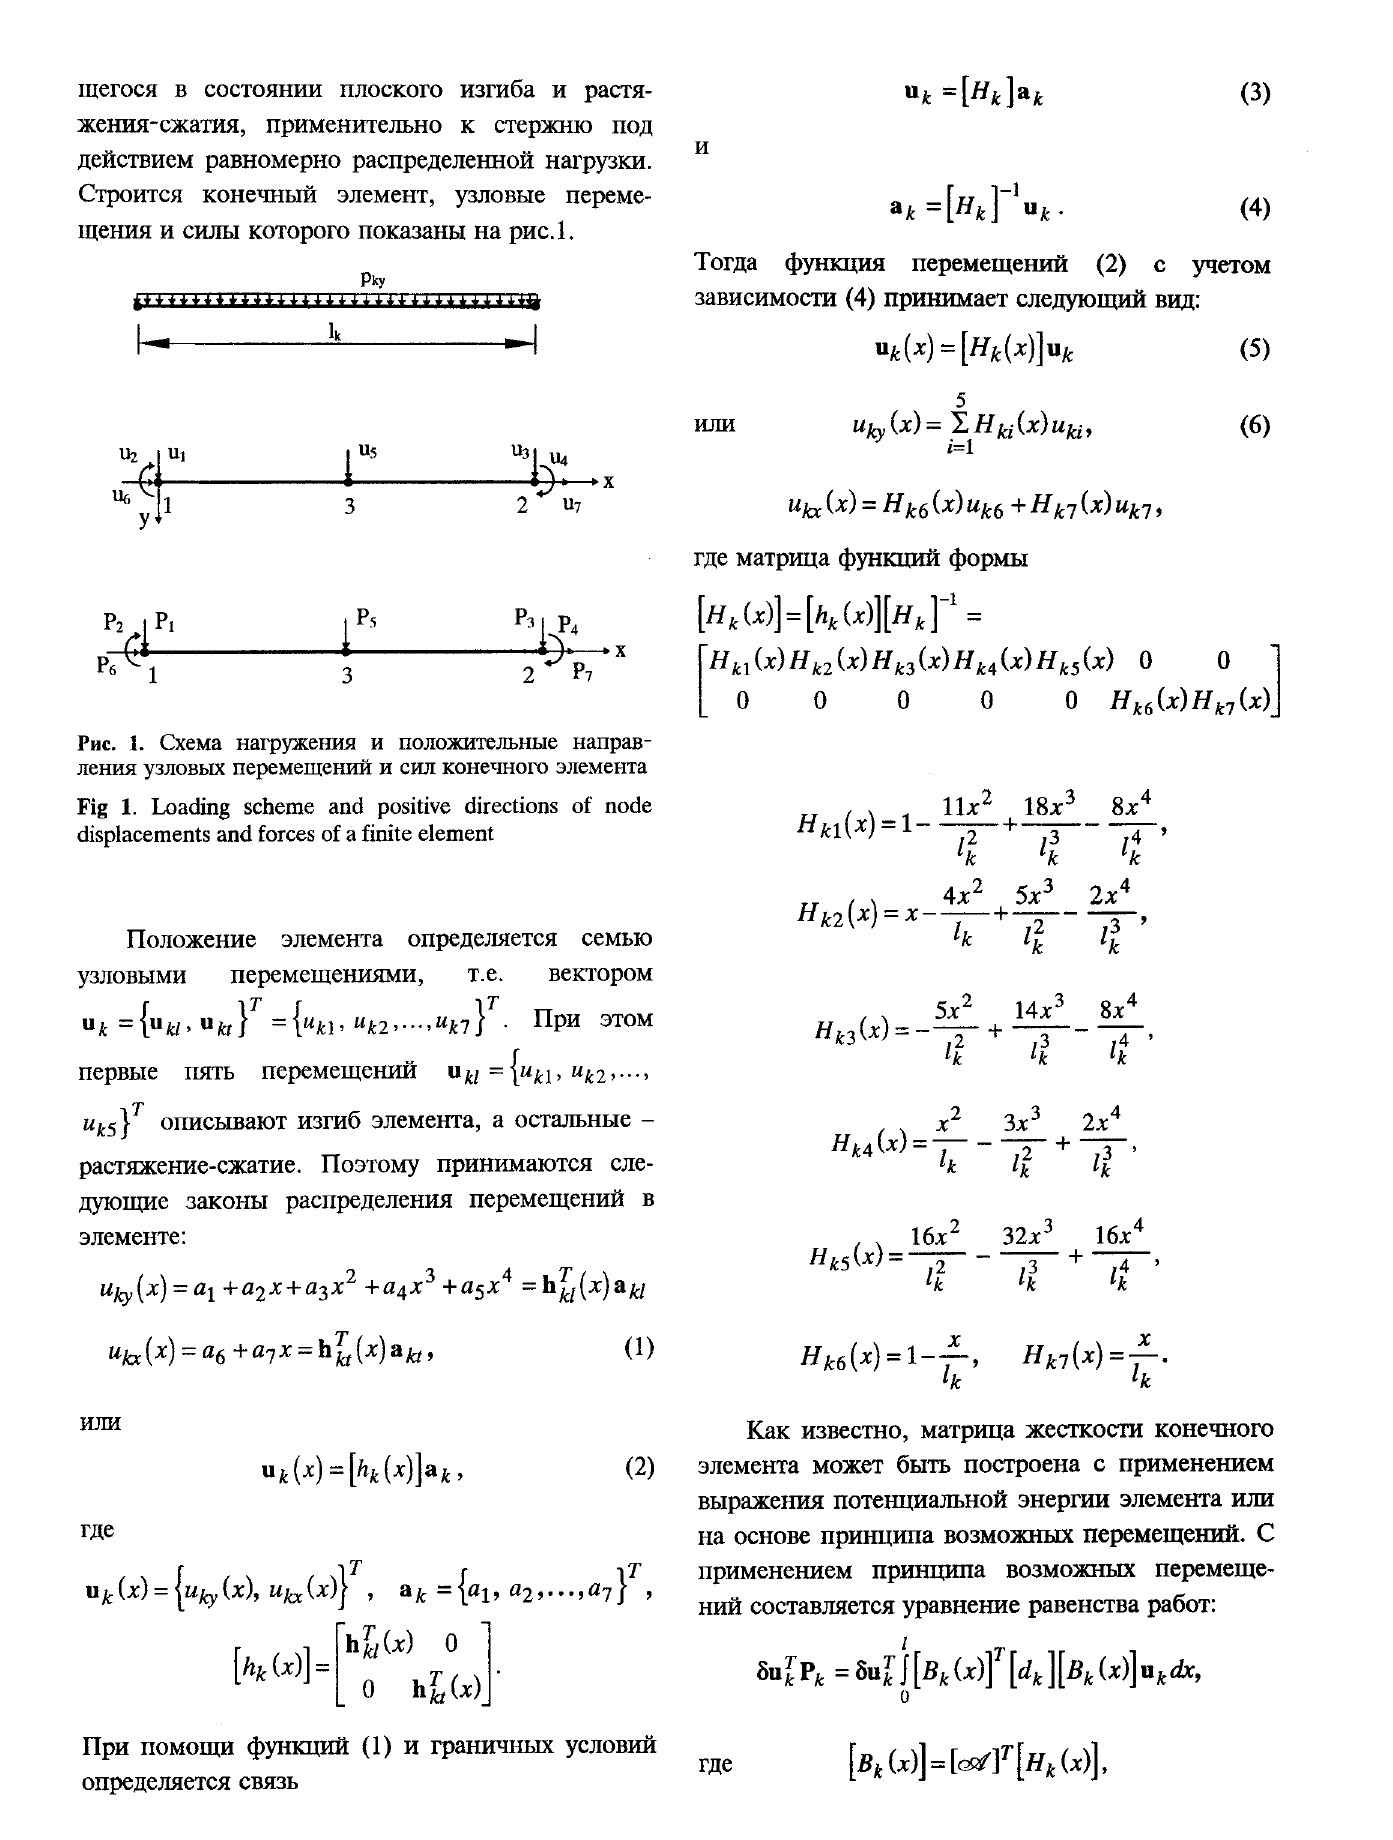
Fig 1. Loading scheme and positive directions of node displacements and forces of a finite